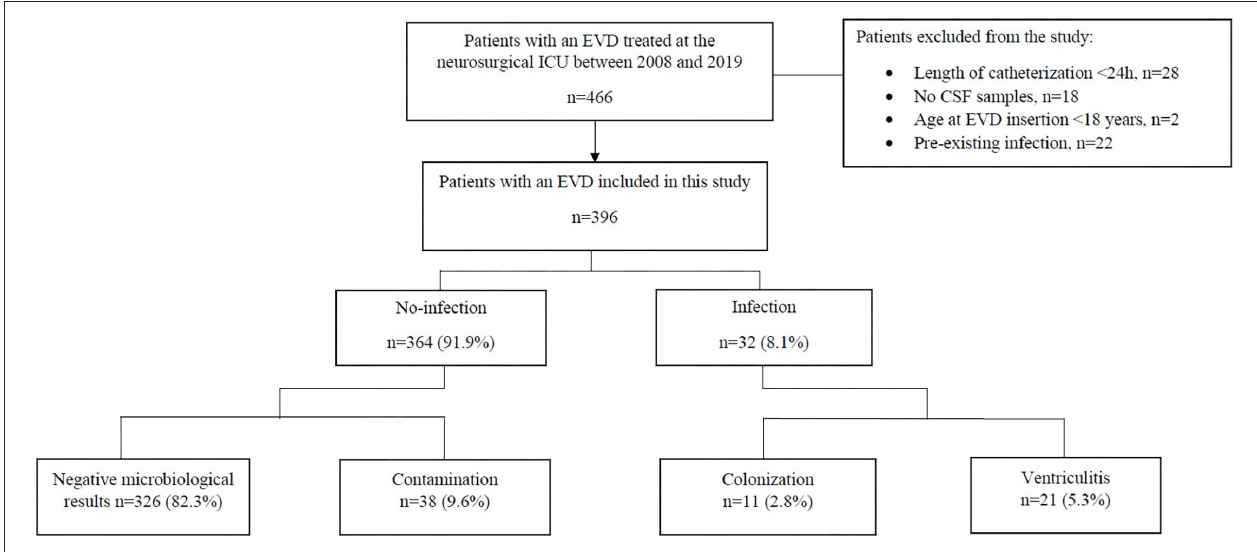
FIGURE 1 | Flow chart showing the study inclusion algorithm. CSF, cerebrospinal fluid; EVD, external ventricular drainage; ICU, intensive care unit.